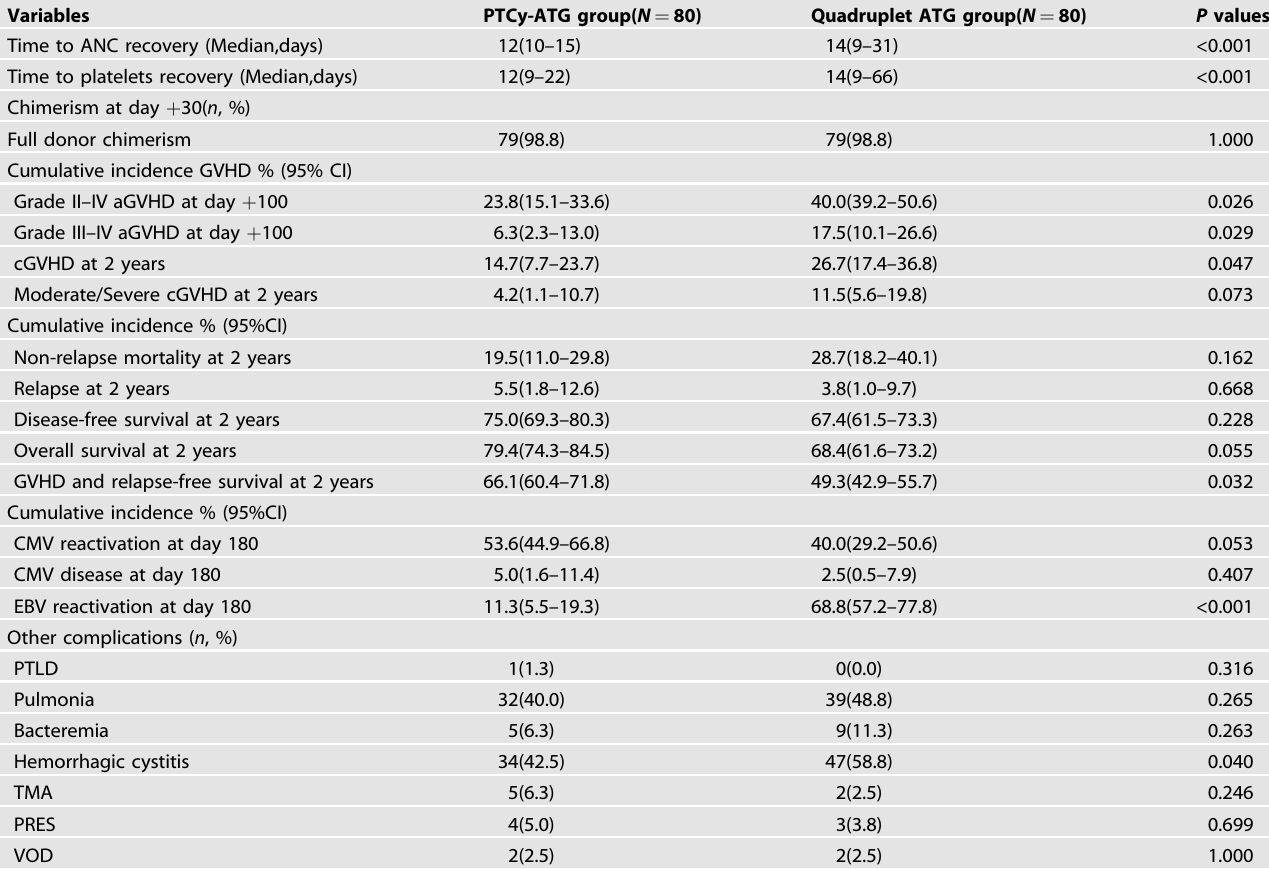
Table 1. Outcomes and complications of two